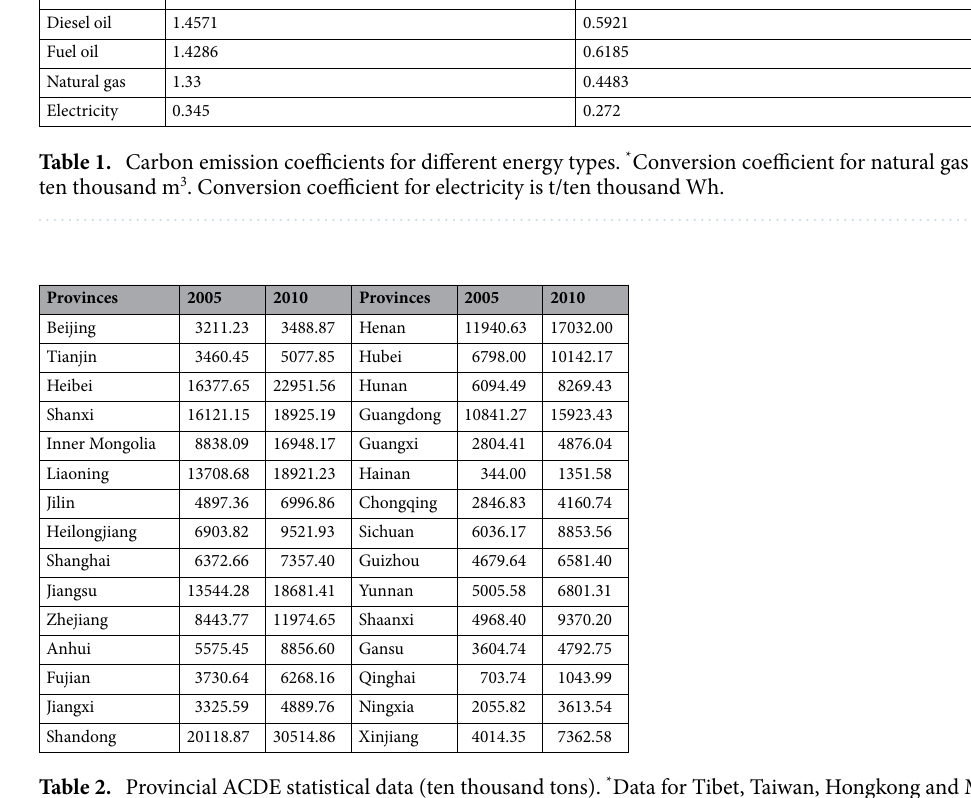
Table 2. Provincial ACDE statistical data (ten thousand tons). * Data for Tibet, Taiwan, Hongkong and Macau are